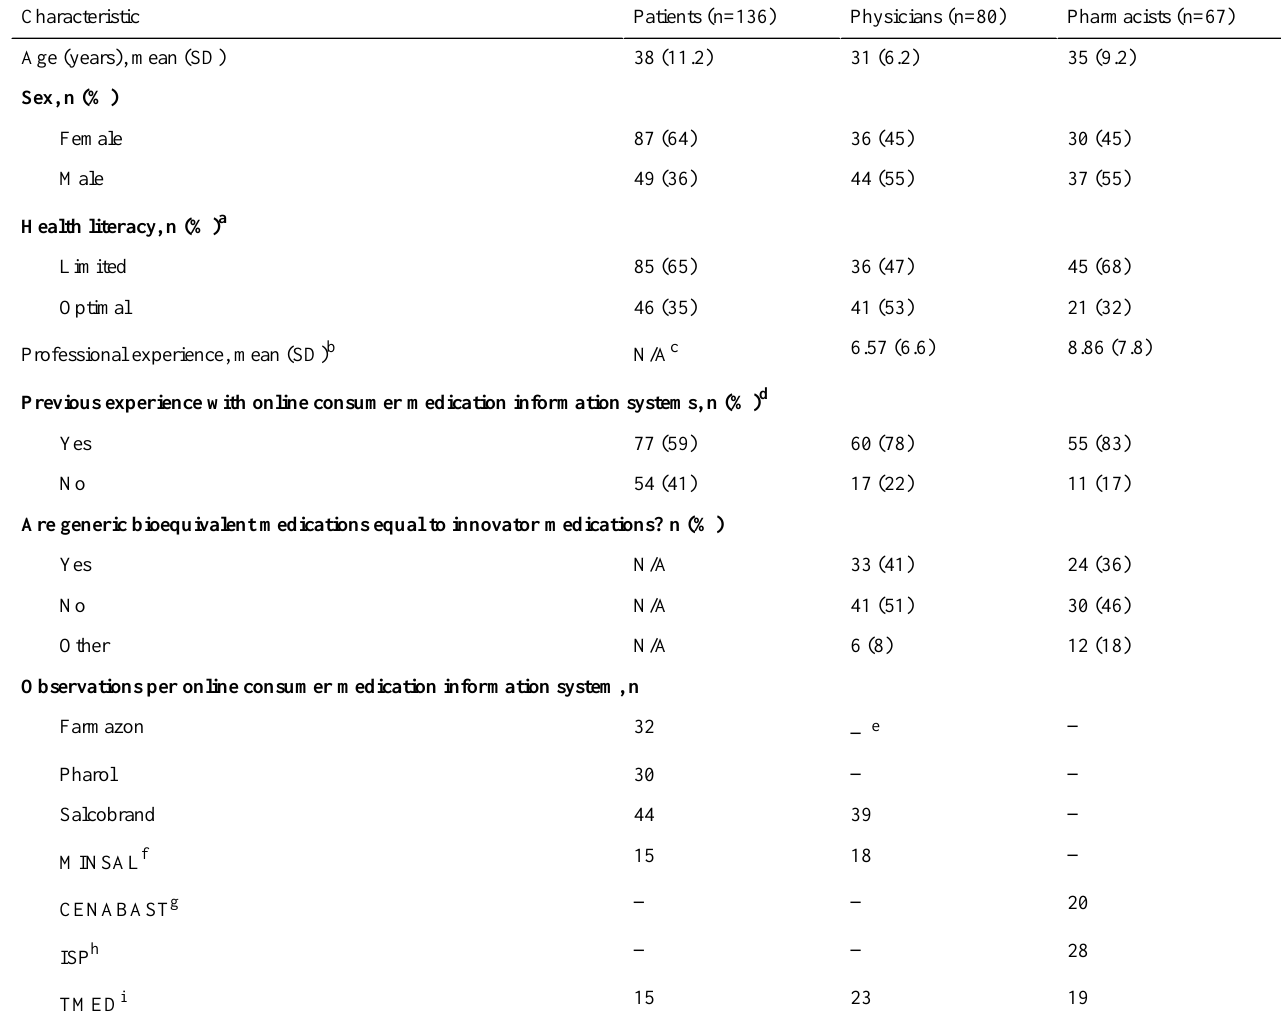
Table 1. Baseline table of the